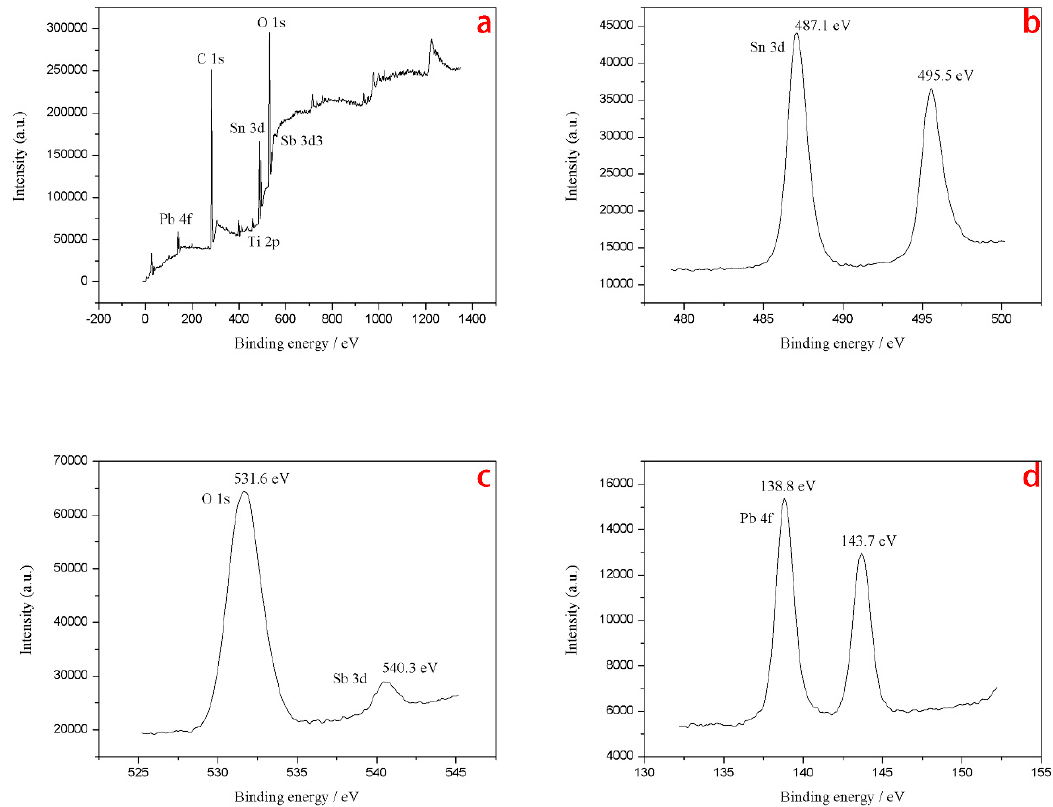
Figure 2. ( a ) XPS spectrum of the porous Ti / SnO 2 –Sb 2 O 3 / PbO 2 electrode; ( b ) XPS spectrum of Sn 3d; ( c ) XPS spectrum of O 1s and Sb 3d; ( d ) XPS spectrum of Pb 4f.